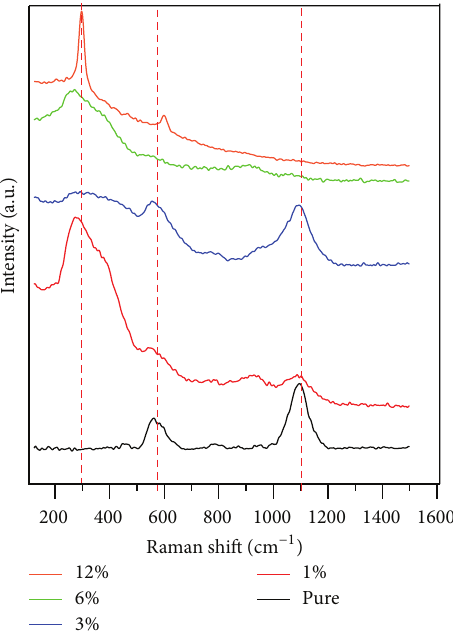
Figure 4: Raman spectra of CdO films at room temperature as a function of saccharin